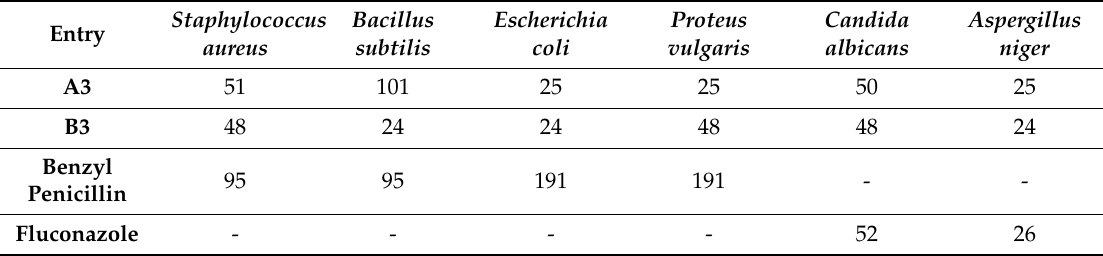
Table 3. Minimum inhibitory concentration (MIC in µ M) of compounds A3 and B3.